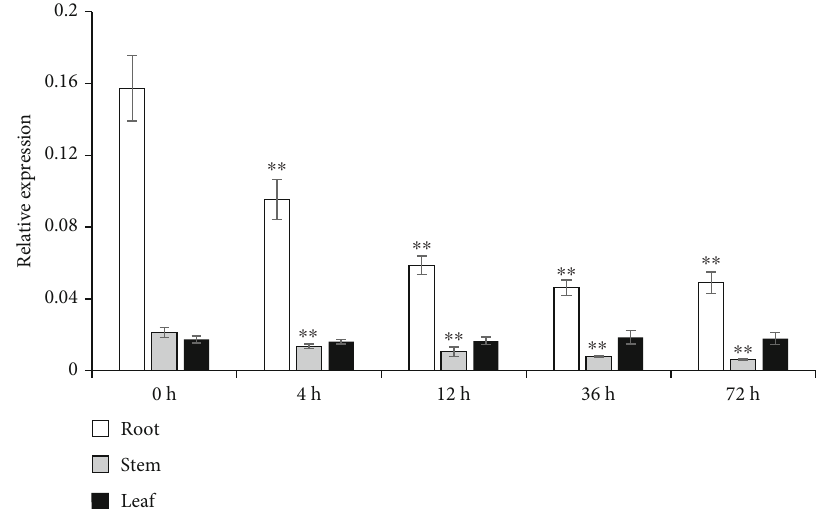
Figure 5: Expression changes of SpuSKOR under K + de fi ciency. 1-year-old purple osier plants were exposed to K + de fi ciency for 4h, 12h, 36h, and 72 h, respectively, before examination. The relative expression level of SpuSKOR was presented after normalization to the internal control. Data are the means of values obtained from three independent replicates ± SE.